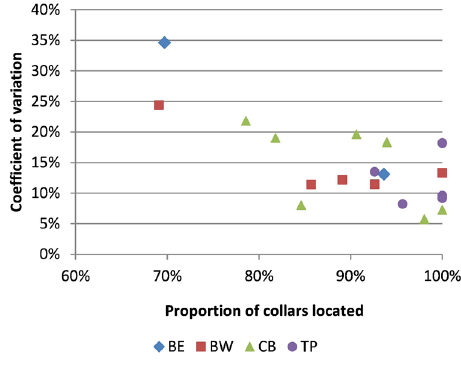
Figure 2. The relationship between proportion of available collars located and estimate precision with herd surveyed, for caribou herds in Northwest Terri- tories and Nunavut, Canada, 2000-2015. Estimates are displayed from the Bluenose-East (BE), Blue- nose-West (BW), Cape Bathurst (CB) and Tuktoyak- tuk Peninsula (TP)